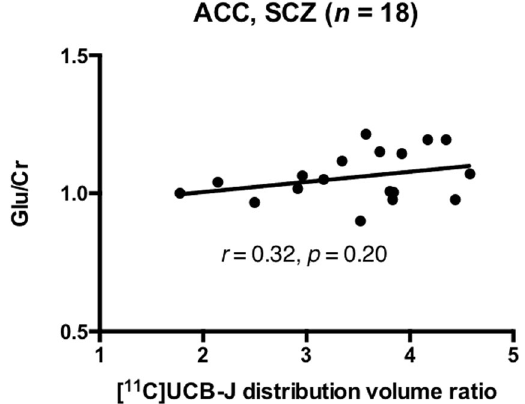
Fig. 4 Synaptic density and glutamate in patients with schizo- phrenia. No signi fi cant relationship between [ 11 C]UCB-J distribution volume ratio and Glu/Cr levels in the left hippocampus in the schizophrenia (SCZ)